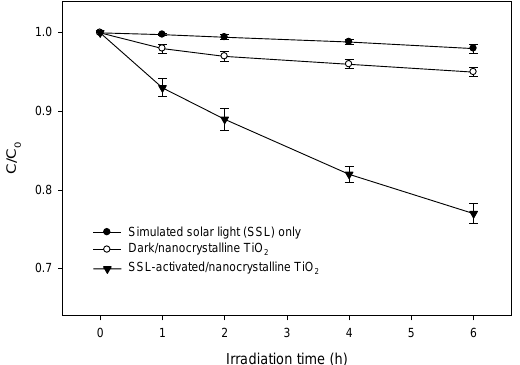
Figure 2. Simulated solar light-activated TiO 2 photocatalysis of lindane. [lindane] 0 = 1.0 µM; mass of TiO 2 film = 9.02 mg; thickness of TiO 2 film = 1.02 µm; area of TiO 2 film = 3750 mm 2 ; pH =